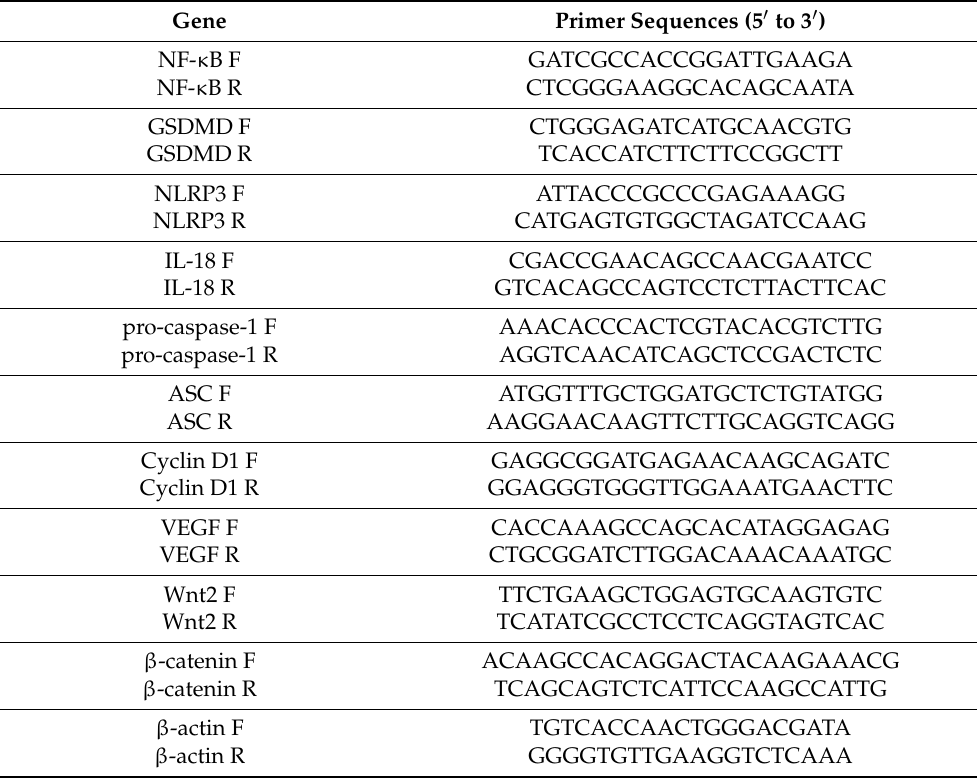
Table 1. Gene-specific primers used in the qPCR. Gene Primer Sequences (5 (cid:48) to 3 (cid:48)